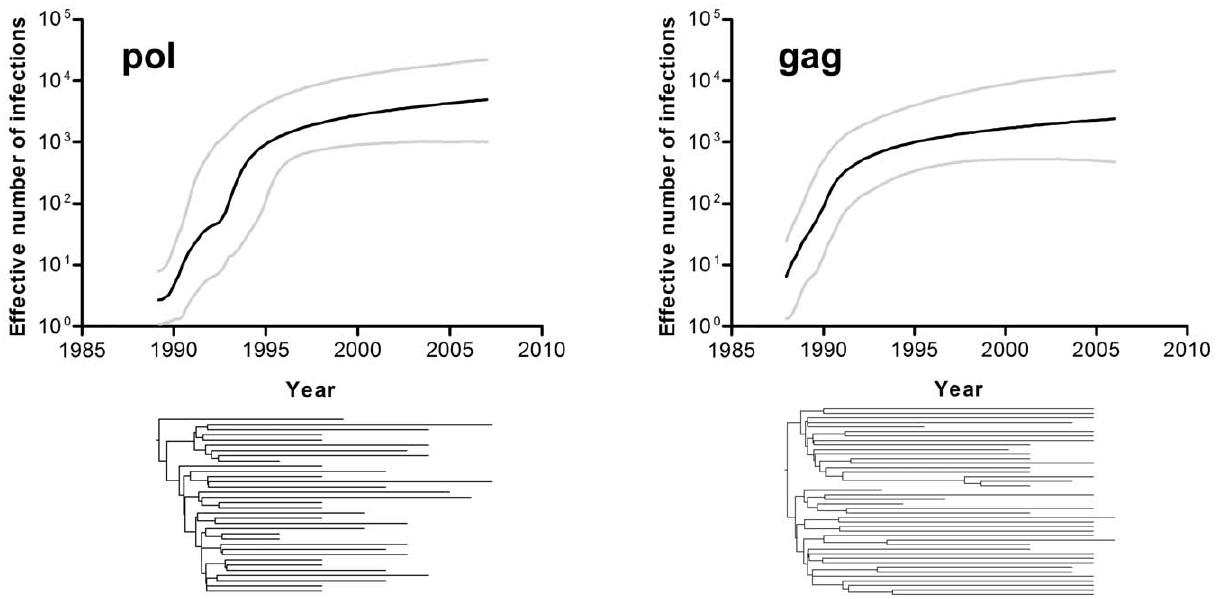
Figure 3. Bayesian skyline plot and phylogenies of the CRF28/29_BF-like HIV-1. Nonparametric reconstruction of the epidemic history with appropriate confidence limits and time-scaled phylogenies of the pol and gag genes are shown. The demographic history of CRF28/29_BF-like HIV-1 is shown as the median estimate of the effective number of infections through time. The median estimate of the effective number of infections is represented in black, and the 95% confidence limits of the estimate are represented in grey. The trees represent the phylogenetic relationships of sequences belonging to the CRF28/29_BF-like lineage. Both sets of data are shown on the same time scale.